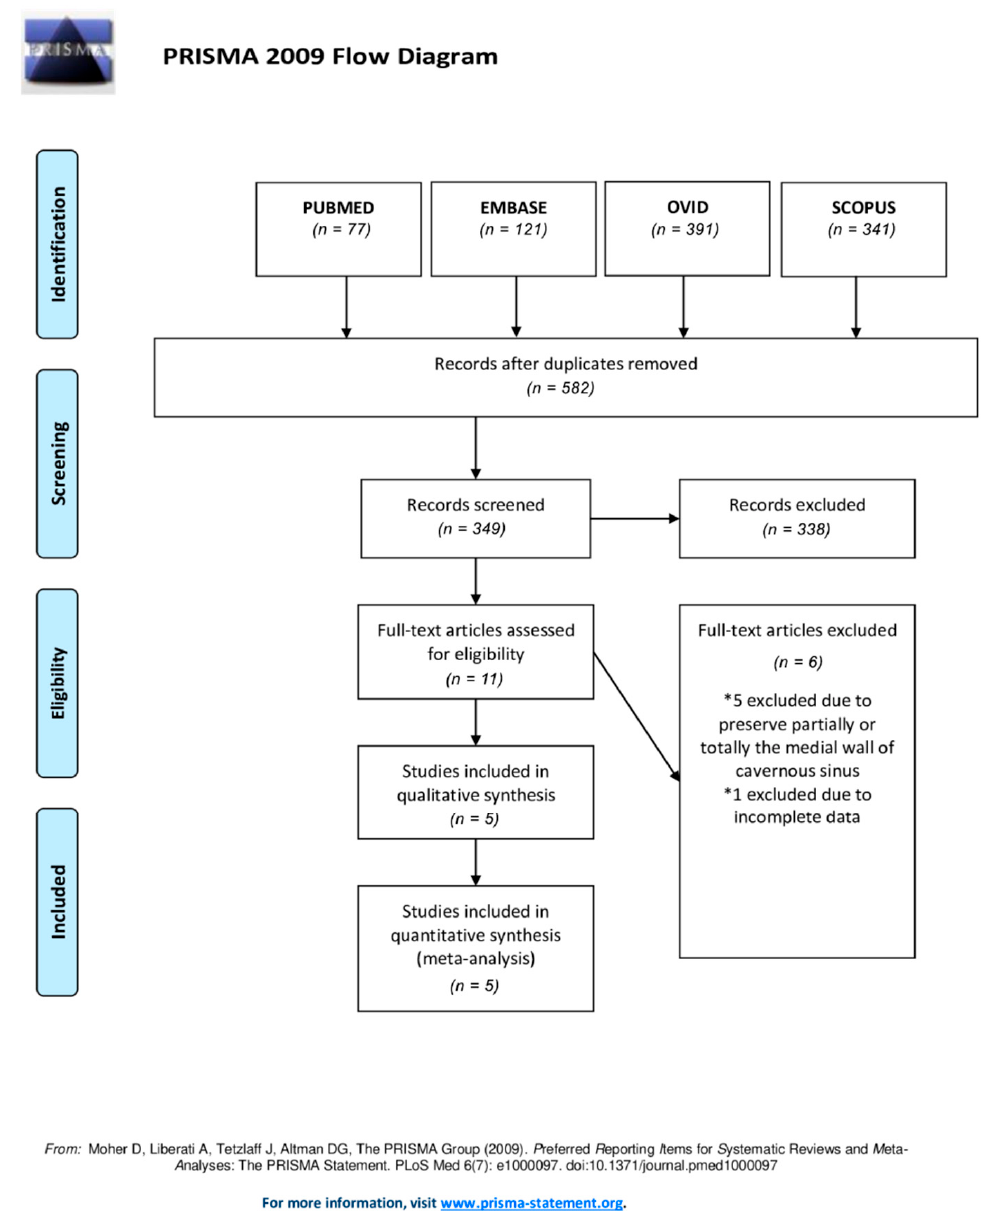
Figure 1. Flow diagram of Preferred Reporting Items for Systematic Reviews and Meta-Analyses (PRISMA) guidelines and protocol.